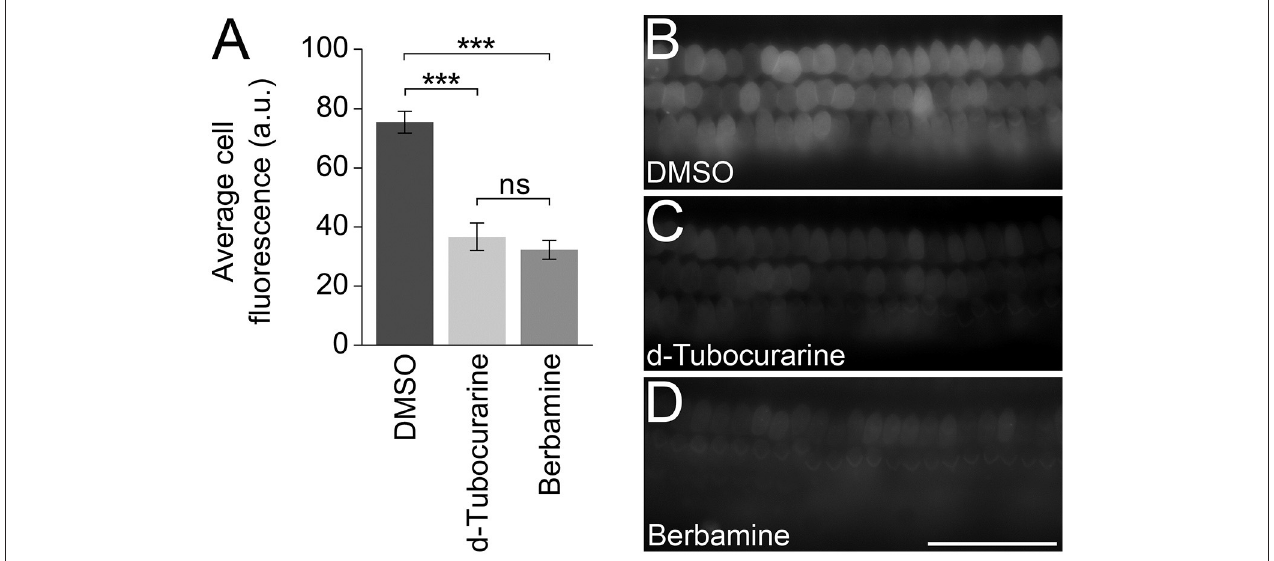
FIGURE 11 | d-Tubocurarine and berbamine reduce the loading of GTTR. (A) dTC and berbamine significantly reduced the fluorescent intensity of 0.2 µ M GTTR compared to DMSO controls (*** p < 0.001). No significant difference was seen between the reduction by dTC and berbamine. Fluorescent intensity was measured in arbitrary units (a.u.). Error bars are ± SEM. (B–D) Representative images taken following 10min GTTR exposure in DMSO, dTC and berbamine. Scale bar = 50 µ